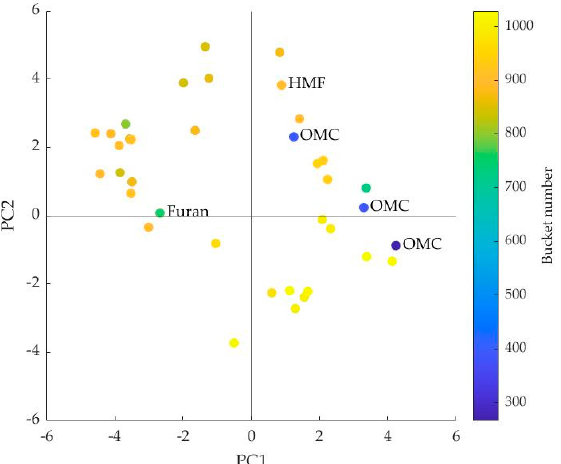
Figure 3. Loadings plot of principal component (PC) 1 and 2; identified buckets are marked with chemical compound.